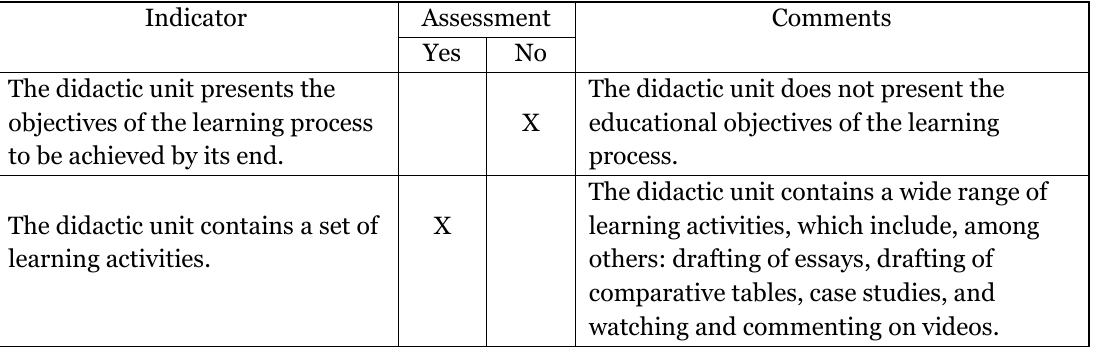
A Fragment of an Assessment Protocol Indicator Assessment